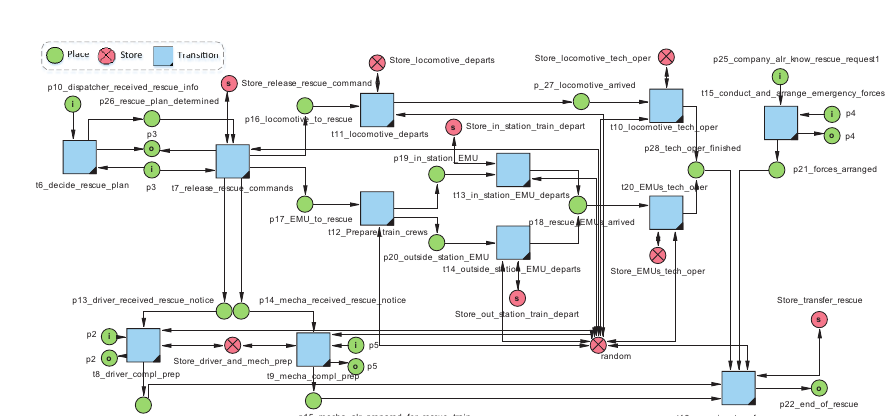
Figure 7. Sub-net of EMUs rescue emergency plan of emergency response and rescue